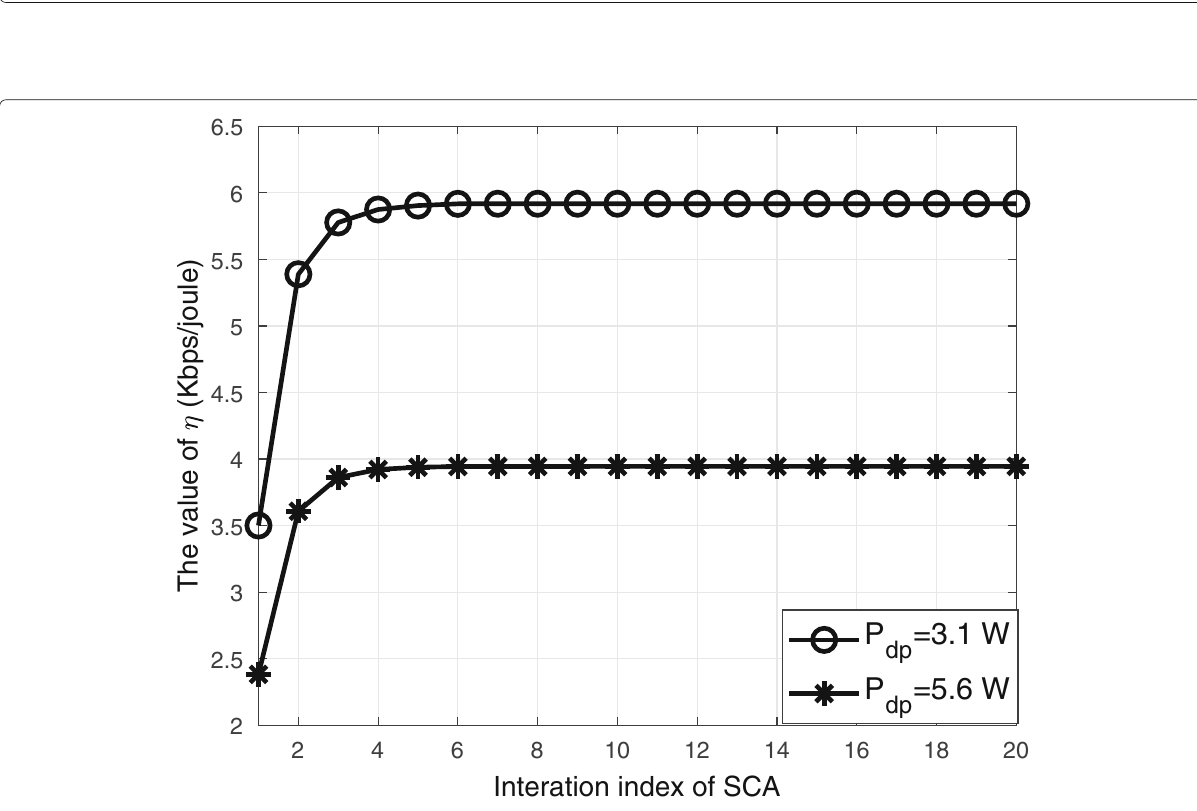
Fig. 4 The convergence of SCA. Convergence behavior of SCA under different P